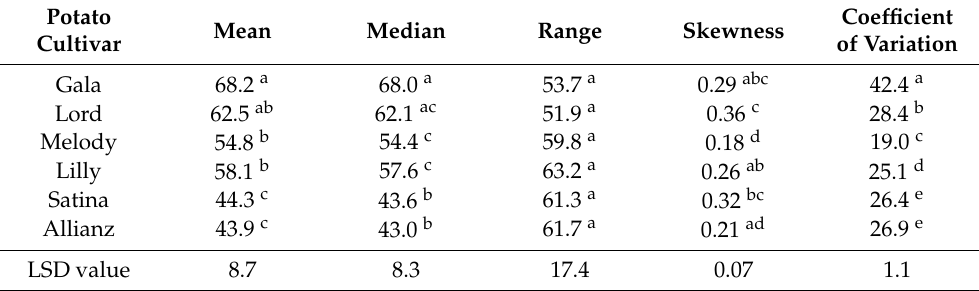
Table 4. Values of basic statistics of pixel distribution along the measurement lines in cold-stored potatoes, depending on potato cultivar (homogeneous groups are labeled with the